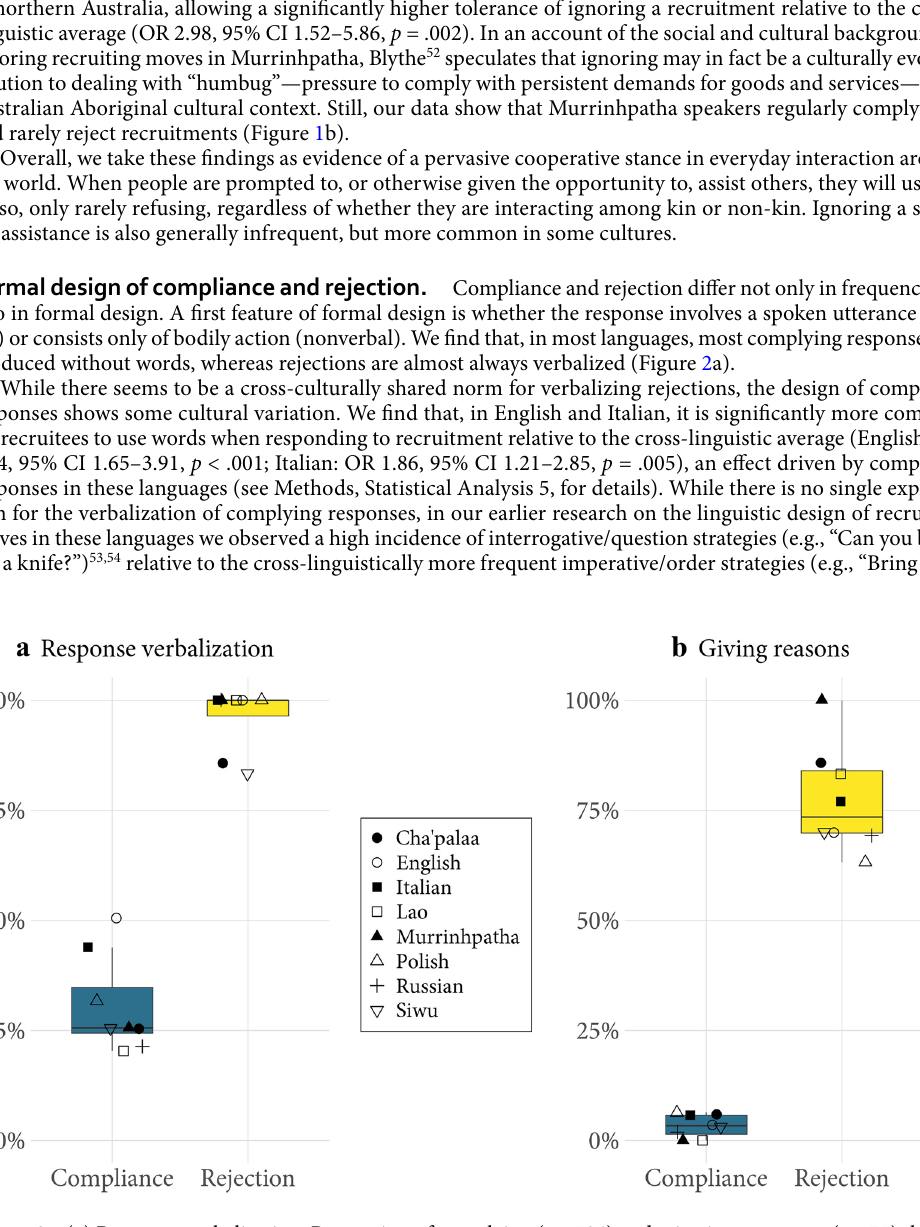
Figure 2. ( a ) Response verbalization. Proportion of complying ( n = 724) and rejecting responses ( n = 75) that involve a verbal component. Each symbol represents the proportion of verbalization for a given response type in the corresponding language. Most complying responses, in most languages, are produced without words, whereas nearly all rejections are verbalized. Only two rejections, one in Cha’palaa and one in Siwu, out of seven and six respectively, were not verbalized. Some responses could not be coded as verbal or nonverbal due to partial information in the recording, for example if the speech was inaudible. ( b ) Giving reasons. Proportion of complying ( n = 737) and rejecting responses ( n = 90) that are accompanied by a reason. Each symbol represents the proportion of reasons for a given response type in the corresponding language. Some responses could